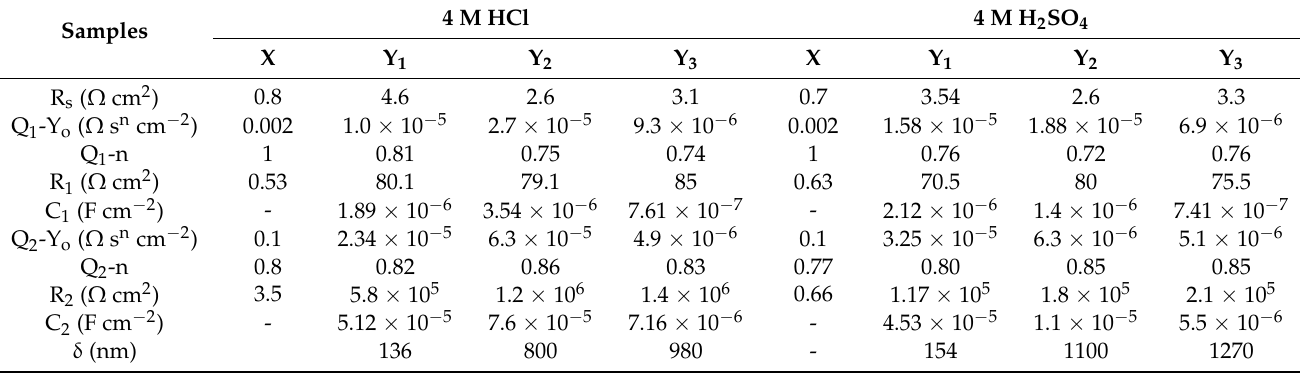
Table 3. Fitting values of EIS